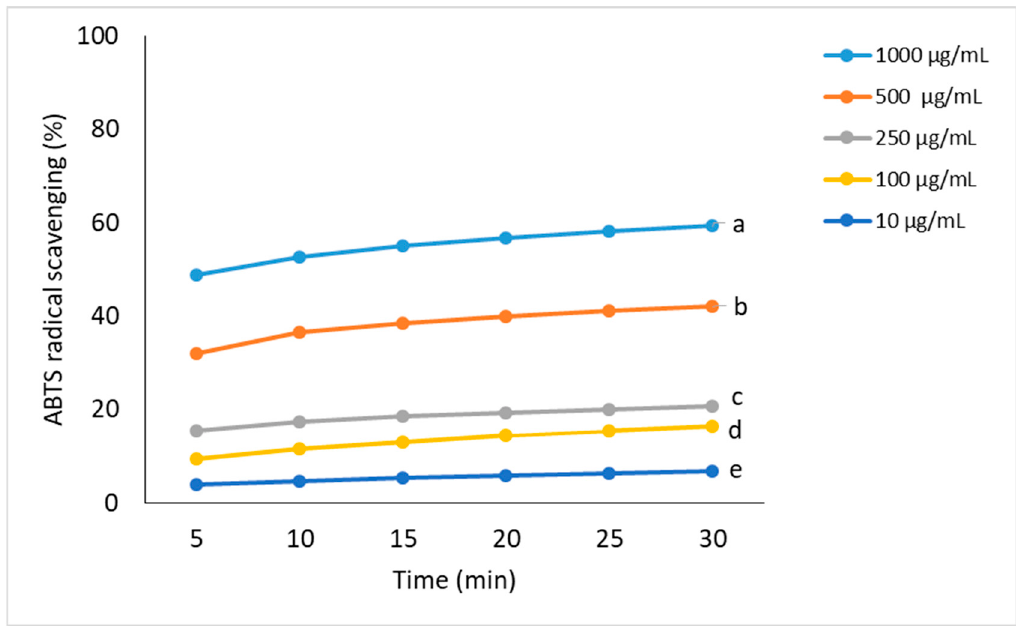
Figure 4. Kinetics of the antioxidant activity changes in the ABTS solutions in the presence of various concentrations of ethanolic extracts from E. angustifolium (FEE). Values are the mean of three replicate determinations ( n = 3). Different letters—values are significantly different, α < 0.05.